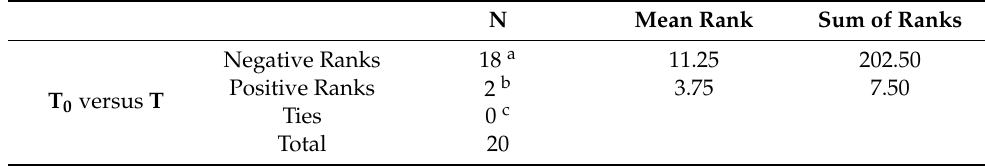
Table 8. Ranks regarding the T 0 and the T operative